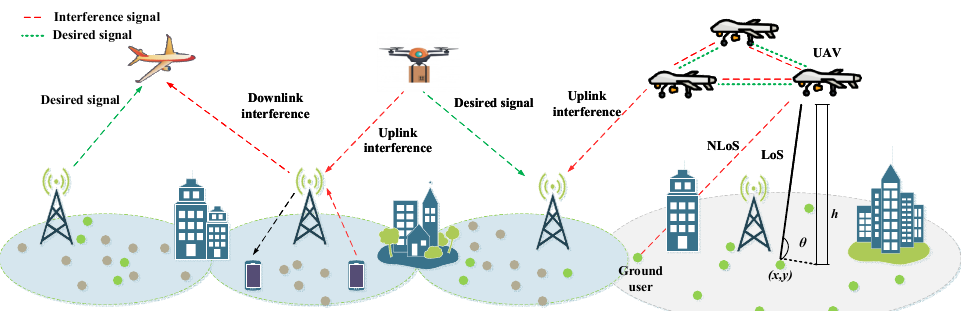
Figure 6. Interference level with connected drones.